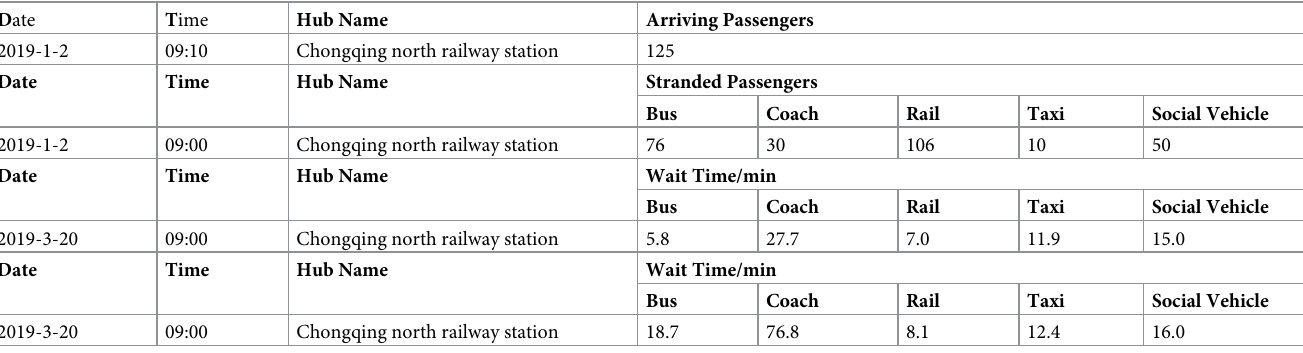
Table 3. Data output